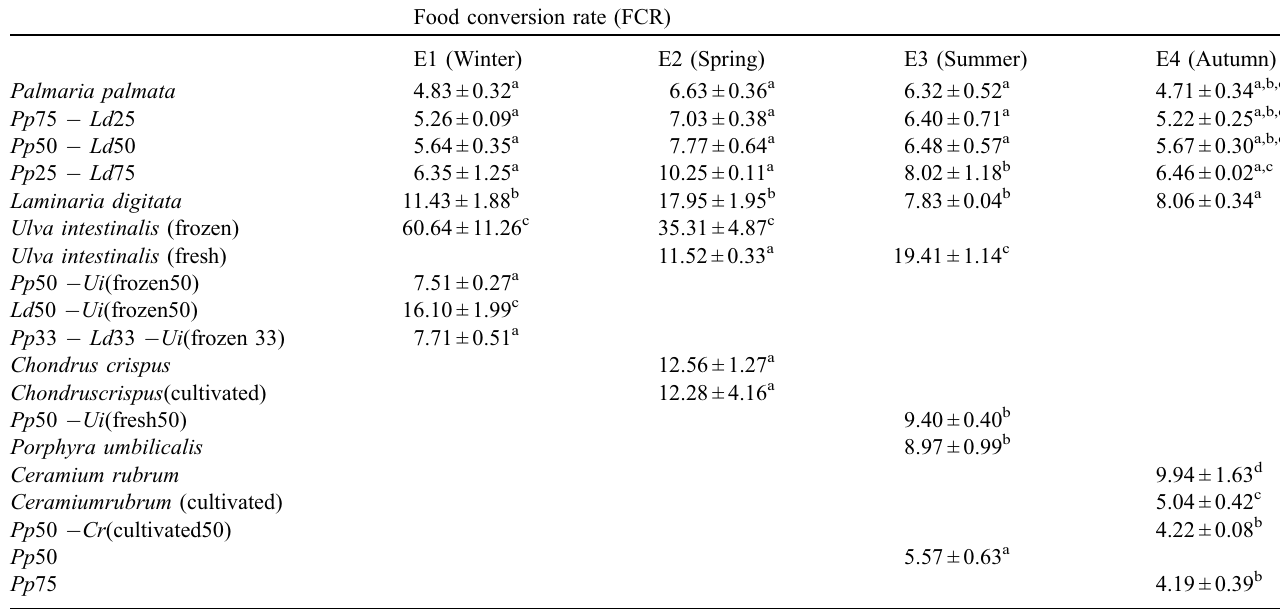
Table 7. Mean and con fi dence interval of food conversionrates ( a = 0.05) by testing period Pp : Palmaria palmata , Ld : Laminaria digitata , Ui : Ulva intestinalis , Cr : Ceramnium rubrum , Pp 25 (cid:3) Ld 75: a diet composed of 25% P. palmata and 75% L. digitata . Pp 75%: diet consisting of 75% of the amount of P. palmata consumed when supplied ad libitum . For each season, diets that do not share a letter signi fi cantly differ (ANOVA and SNK tests, p <